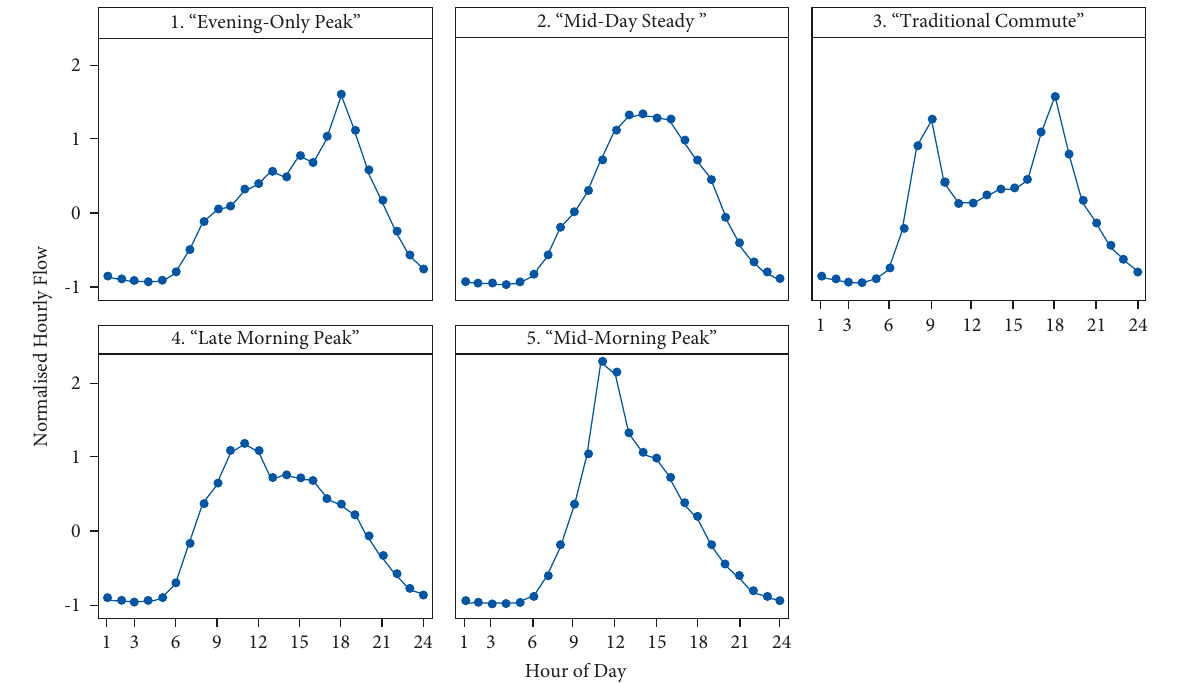
Figure 6: Average daily flow profile of each